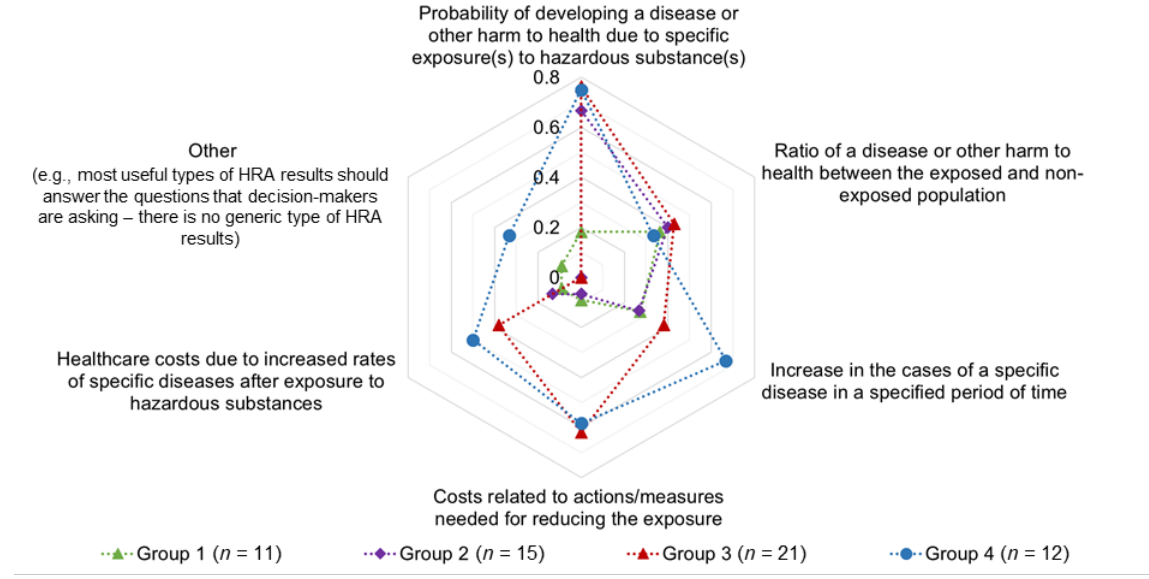
Figure 1. Most useful types of HRA results for decision-making—proportions of responses from the four groups.